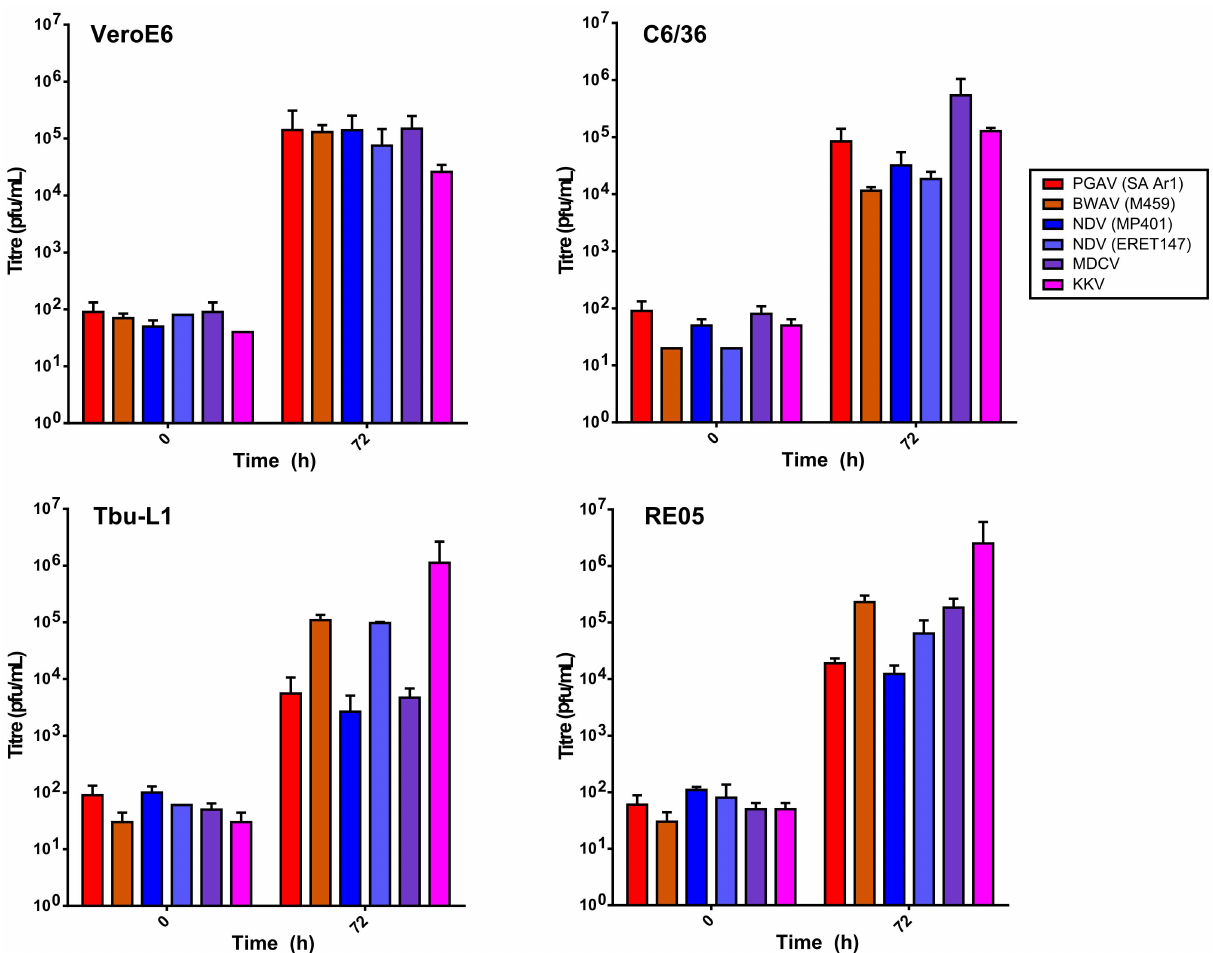
Figure 4. Comparison of virus growth in various cell lines. Cell lines derived from bats (i.e. Tb 1 Lu and RE05), mosquito (i.e. C6/36) or non- human primates (i.e. VeroE6) were infected with the indicated viruses at a multiplicity of infection of 0.1. Supernatants were harvested either immediately after infection (0 h) or after 72 h incubation and titres were determined using plaque assay.